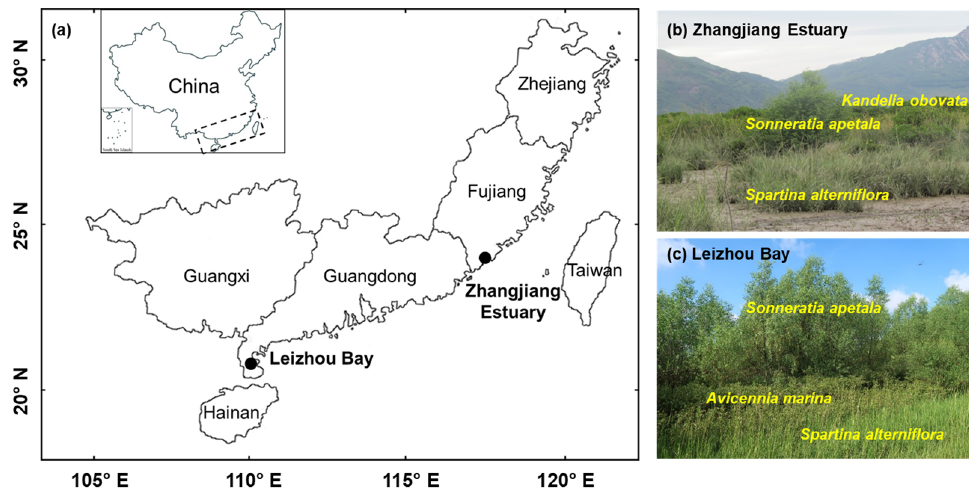
Figure 1. The study sites. ( a ) Map of southern China, showing the locations of the two study sites. Photographs of vegetation at ( b ) Zhangjiang Estuary, showing an individual Sonneratia apetala plant (~3 years old) growing amid native mangroves and Spartina alterniflora , and ( c ) Leizhou Bay, showing a large stand of Sonneratia apetala plants (4~5 years old and reproductive) encroaching upon native mangroves, with Spartina alterniflora in the forefront of the